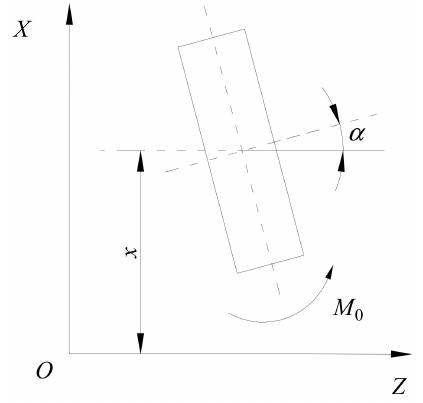
Figure 3. Motion relationships of the